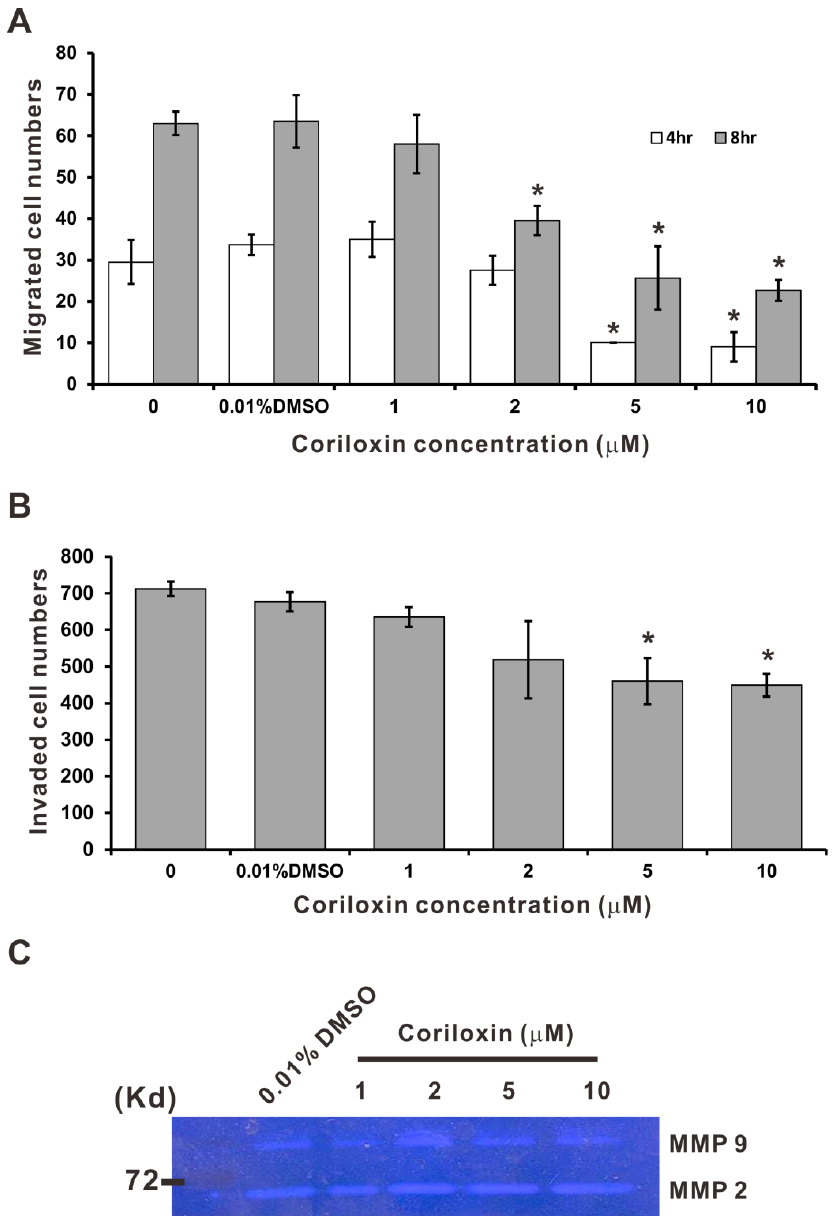
Figure 4. Antimigratory and anti-invasive effects of coriloxin on CL1-5 cells. ( A ) Wound-healing assay of the coriloxin-treated CL1-5 cells. We counted cells migrating into the wound area 4 and 8 h after wounding. ( B ) Cell invasion effects exerted by coriloxin (indicated concentrations). The data are representative of three independent experiments and are indicated as the mean ± SD. * p < 0.05 indicates a significant difference from the solvent control group (0.01% DMSO). ( C ) Gelatin zymography assay of MMP-2 and MMP-9 activities in coriloxin-treated cells.